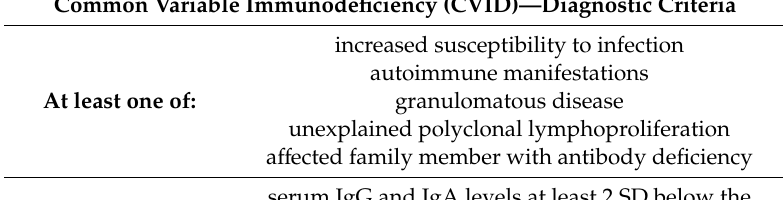
Table 2. Common variable immunodeficiency (CVID)—diagnostic criteria according to ESID (European Society for Immunodeficiencies)